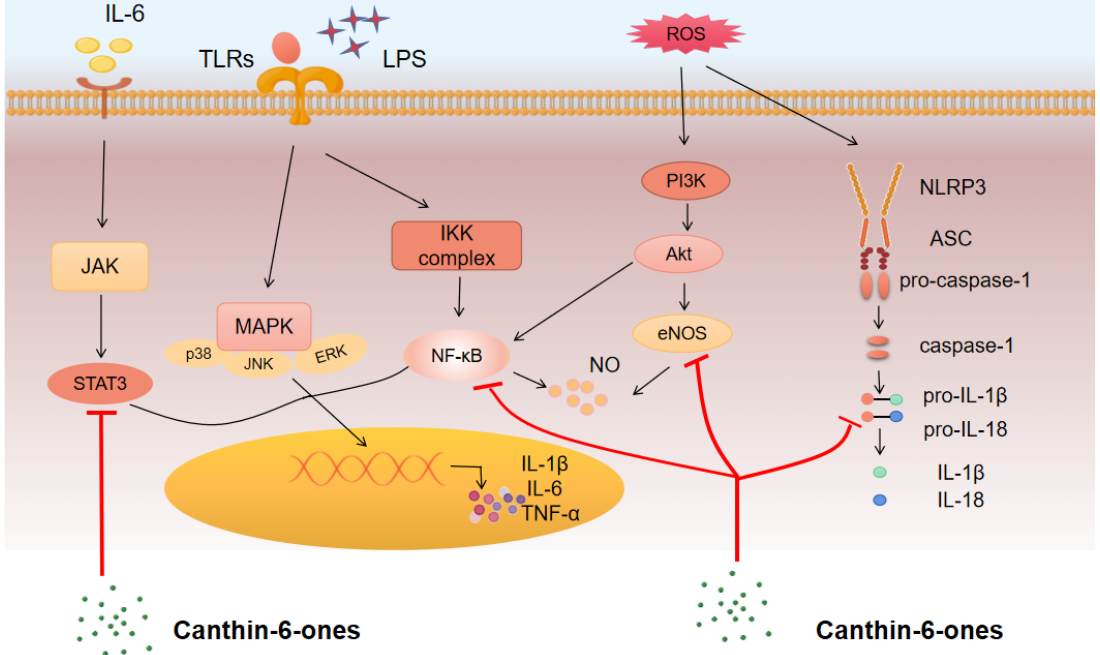
Figure 2. Canthin-6-ones regulate multiple signaling pathways involved in inflammation. Canthin-6-one and its many derivatives suppress the production of pro-inflammatory cytokines by targeting the activation of various signaling pathways, such as the NF- κ B, JAK/STAT, and MAPK pathways. The inhibitory role of canthin-6-one in the PI3K–AKT pathway may be a concomitant event that occurs simultaneously with the inhibition of other inflammatory pathways induced by canthin-6-one. The NLRP3 inflammasome was also recently shown to be a target of canthin-6-one, which suppresses both the production and the activation of NLRP3 inflammasome components. Canthin-6-one suppresses the phosphorylation of Rac1, a key signaling molecule of the Rho–Rock pathway in inflammation and endothelial stabilization, indicating a role of this compound in endothelial